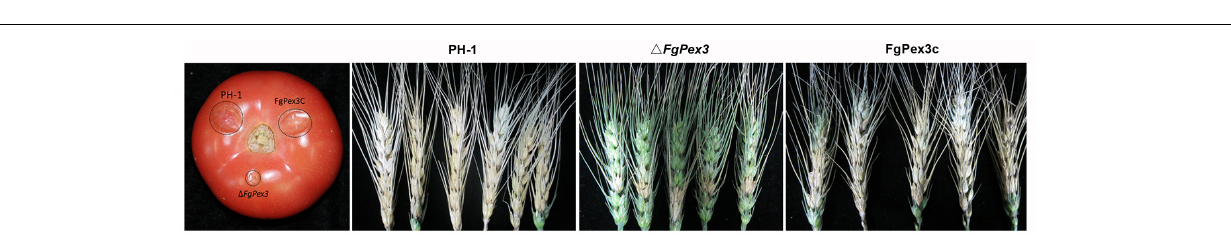
DON accumulation in the FgPex3 deletion mutant, no significant difference in DON production among the wild type, (cid:49) FgPex3 mutant and the complemented strain FgPex3C was observed ( Figure 7 ). This indicates that DON production is still possible and does not require FgPex3